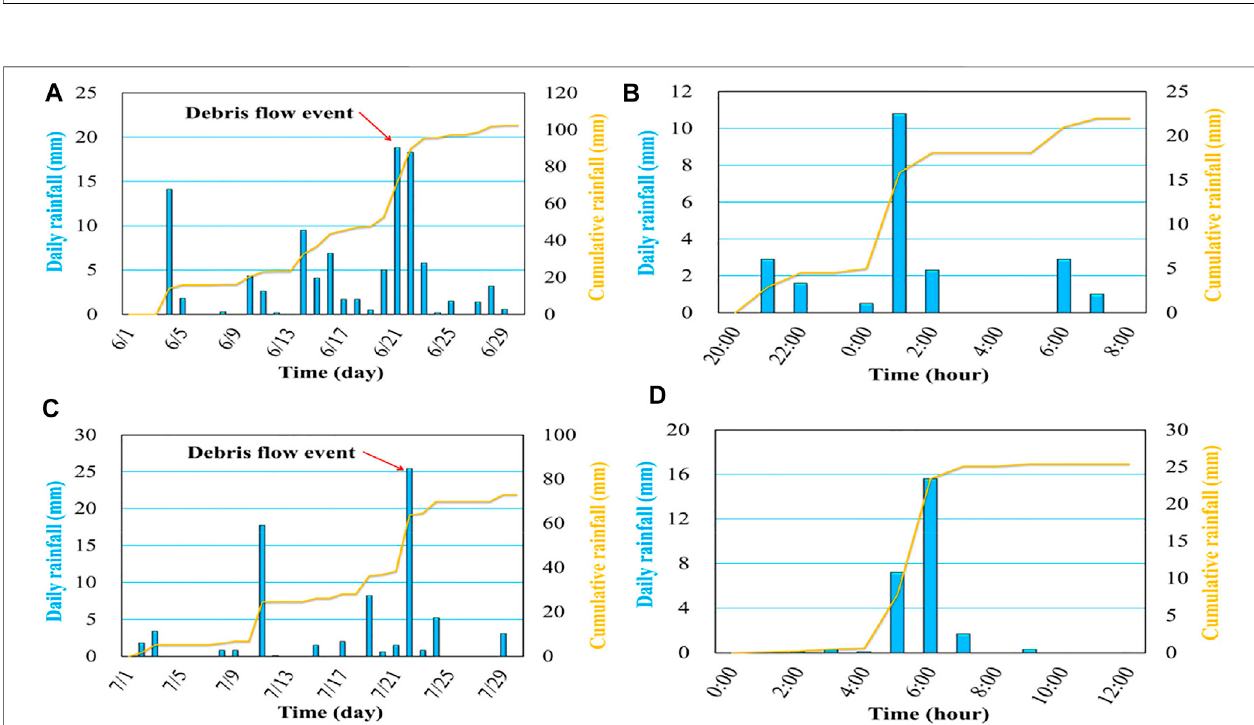
FIGURE2| Distributionofdailyandhourlyrainfall. (A) DailyrainfallinJune2019recordedbytheZechawaprecipitationstation; (B) Hourlyrainfallfrom20:00(Beijing time) on June 20 to 8:00 (Beijing time) on June 21, 2019 recorded by the Zechawa precipitation station; (C) Daily rainfall in July 2019 recorded by the Zharu Temple precipitation station; (D) Hourly rainfall from 00:00 to 12:00 (Beijing time) on July 22, 2019 recorded by the Zharu Temple precipitation station.